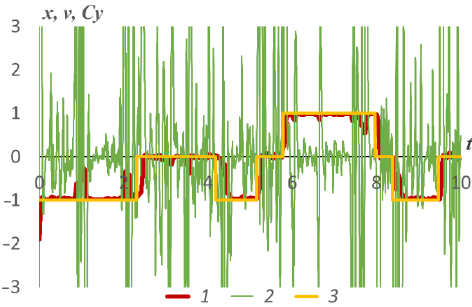
Figure 4. Typical controlled state trajectories with low control cost: 1—coordinate x t ; 2—velocity v t ; 3—desired “ideal” trolley movement Cy t